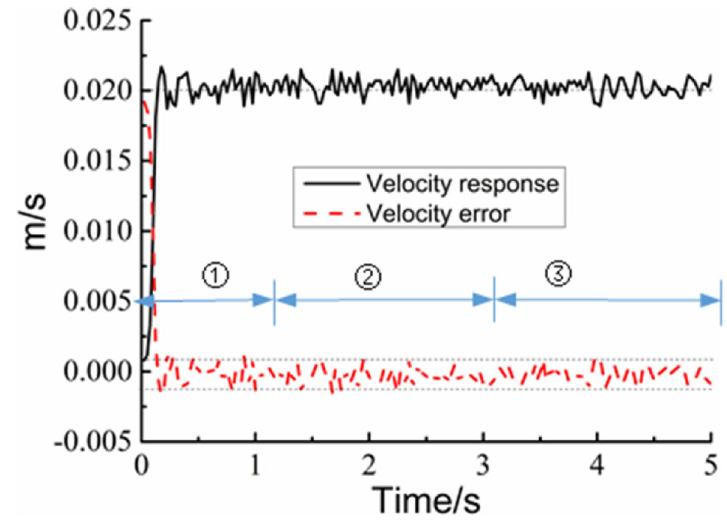
Fig. 9 Speed response under 0.01 m/s